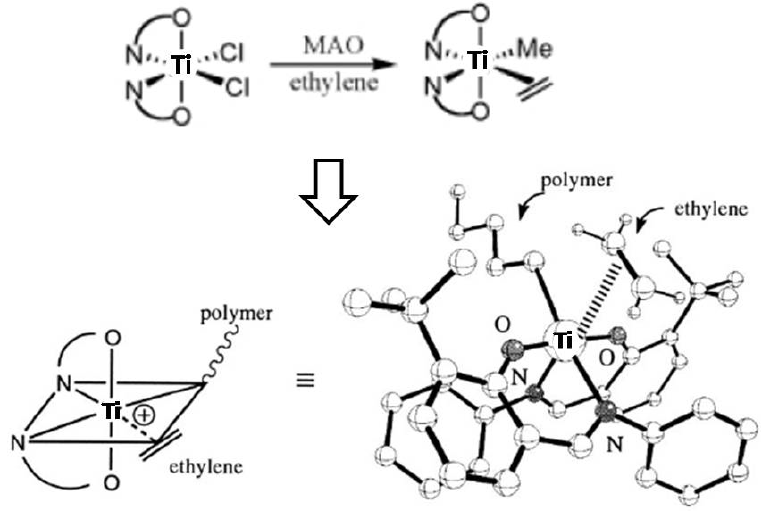
Figure 4. Structure and possible active species of titanium complex